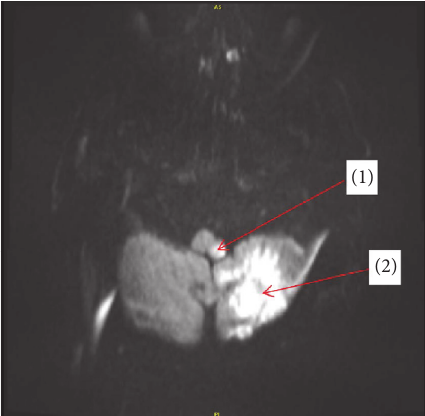
Figure 1: Axial diffusion weighted imaging sequence of a magnetic resonance imaging scan of the brain demonstrates hyperintensity in various brain areas. Those findings are consistent with an acute stroke in the left medullary restiform body (1) and left cerebellar hemisphere (2).